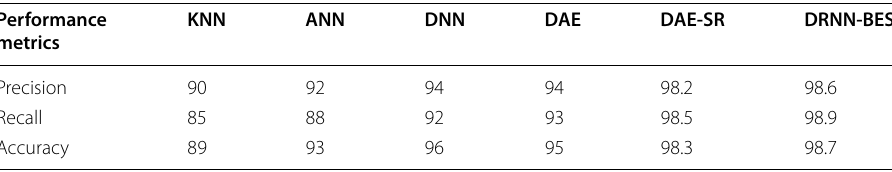
Table 6 Cosine similarity based performance